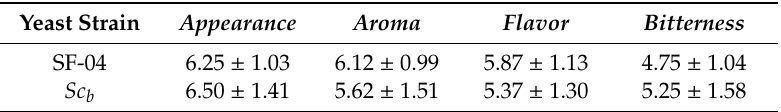
Table 4. Sensory evaluation results for the beers produced with the Saccharomyces cerevisiae (SF-04) and Saccharomyces cerevisiae var. boulardii ( Sc b ) strains. Scale from 1 (extremely dislike attribute) to 9 (extremely like attribute). Results expressed as mean ± standard deviation. No significant di ff erences ( p < 0.05) between row and column values were